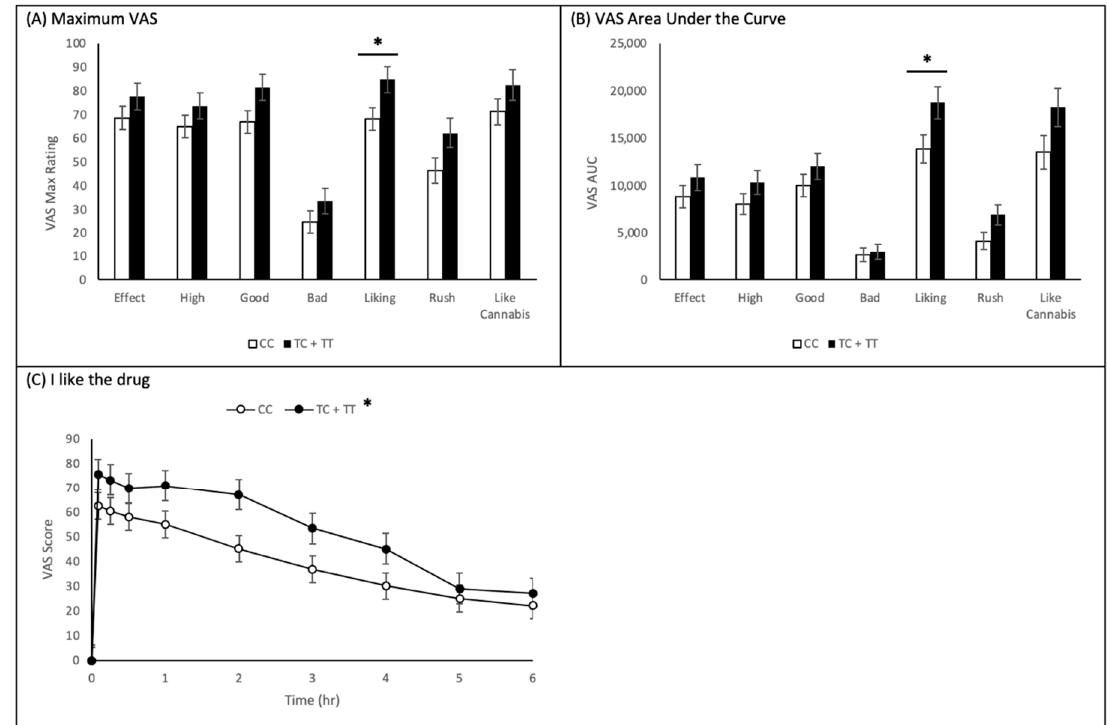
Figure 2. Impact of CNR1 rs1049353 (TC + TT vs. CC) on Subjective Effects of Cannabis. VAS measurements (ranging from Not at all to Extremely (0 to 100)) were collected at different time points during acute cannabis intoxication (0–6 h) of n = 52 subjects, separated by rs1049353 genotype. ( A ) Maximum values of VAS scores obtained with various questions. Unadjusted maximum VAS question results: I feel a drug effect ( p = 0.226), I feel this high ( p = 0.235), I feel the drug’s good effects ( p = 0.053), I feel the drug’s bad effects ( p = 0.226), I like the drug ( p = 0.027), I feel a rush ( p = 0.057), and It feels like cannabis ( p = 0.194). ( B ) Area under the curve analysis for VAS values collected. Unadjusted mixed-effects model AUC results: I feel a drug effect ( p = 0.269), I feel this high ( p = 0.181), I feel the drug’s good effects ( p = 0.266), I feel the drug’s bad effects ( p = 0.739), I like the drug ( p = 0.036), I feel a rush ( p = 0.054), and It feels like cannabis ( p = 0.083). ( C ) Time course of the scoring for the VAS question ‘I like the drug’… Unadjusted mixed-effects model time course results of I like the drug . * p < 0.05, TC + TT vs. CC.